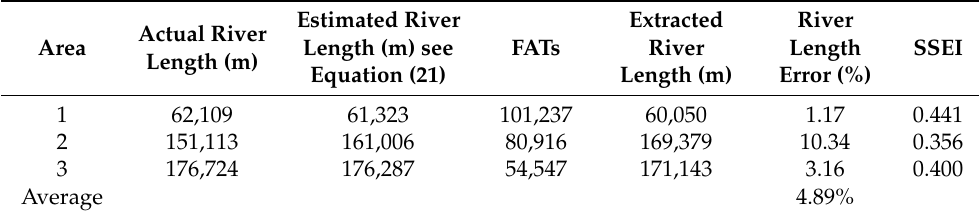
Table 3. Statistical criteria values for the comparison of the calculated and actual river length in Hubei